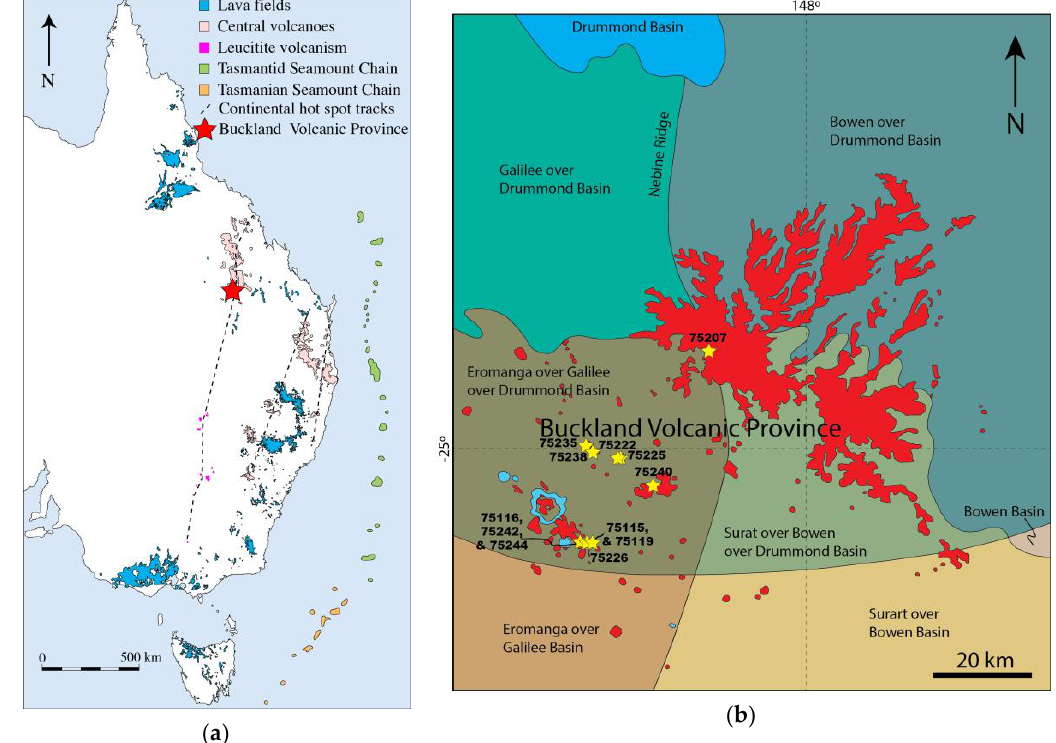
Figure 1. ( a ) Locations of late Mesozoic and Cenozoic intraplate volcanic provinces throughout eastern Australia [29,38,45]. The hotspot tracks are from [38], seamount locations are from [45], and Buckland volcanic province is shown by a red star. ( b ) A close-up of Buckland volcanic province, showing basement domains and locations of samples as yellow stars. Red regions are basaltic material and blue regions are gabbro outcrops, after [41].